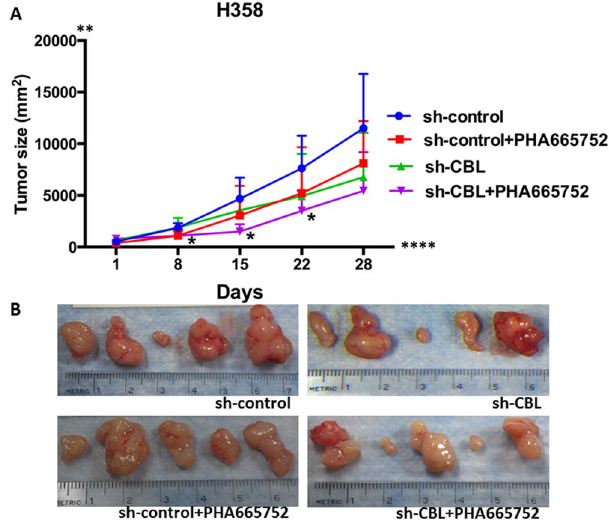
Figure 8. Tumor inhibition by MET inhibitor PHA665752 in vivo . (A) Tumor from sh-CBL, sh-CBL treated with PHA665752, and sh-control treated with PHA665752 groups showed growth inhibition compared with the sh-control group. * p < 0.05 (B) Photographs of tumors from 5 mice of each group: sh-control, sh-control treated with PHA665752, sh-CBL, and sh-CBL treated with